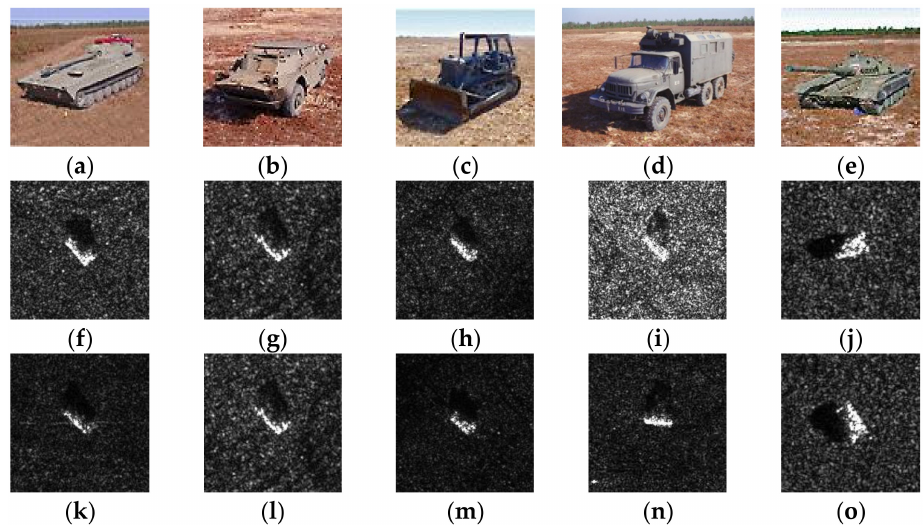
Figure 3. Examples of samples from dataset 2. ( a – e ) Display the optical slices from five types of objects. ( f – j ) Show objects with aspect angles 0 to 45 ◦ from source domain. ( k – o ) Show objects with aspect angles 180 to 225 ◦ from target domain.